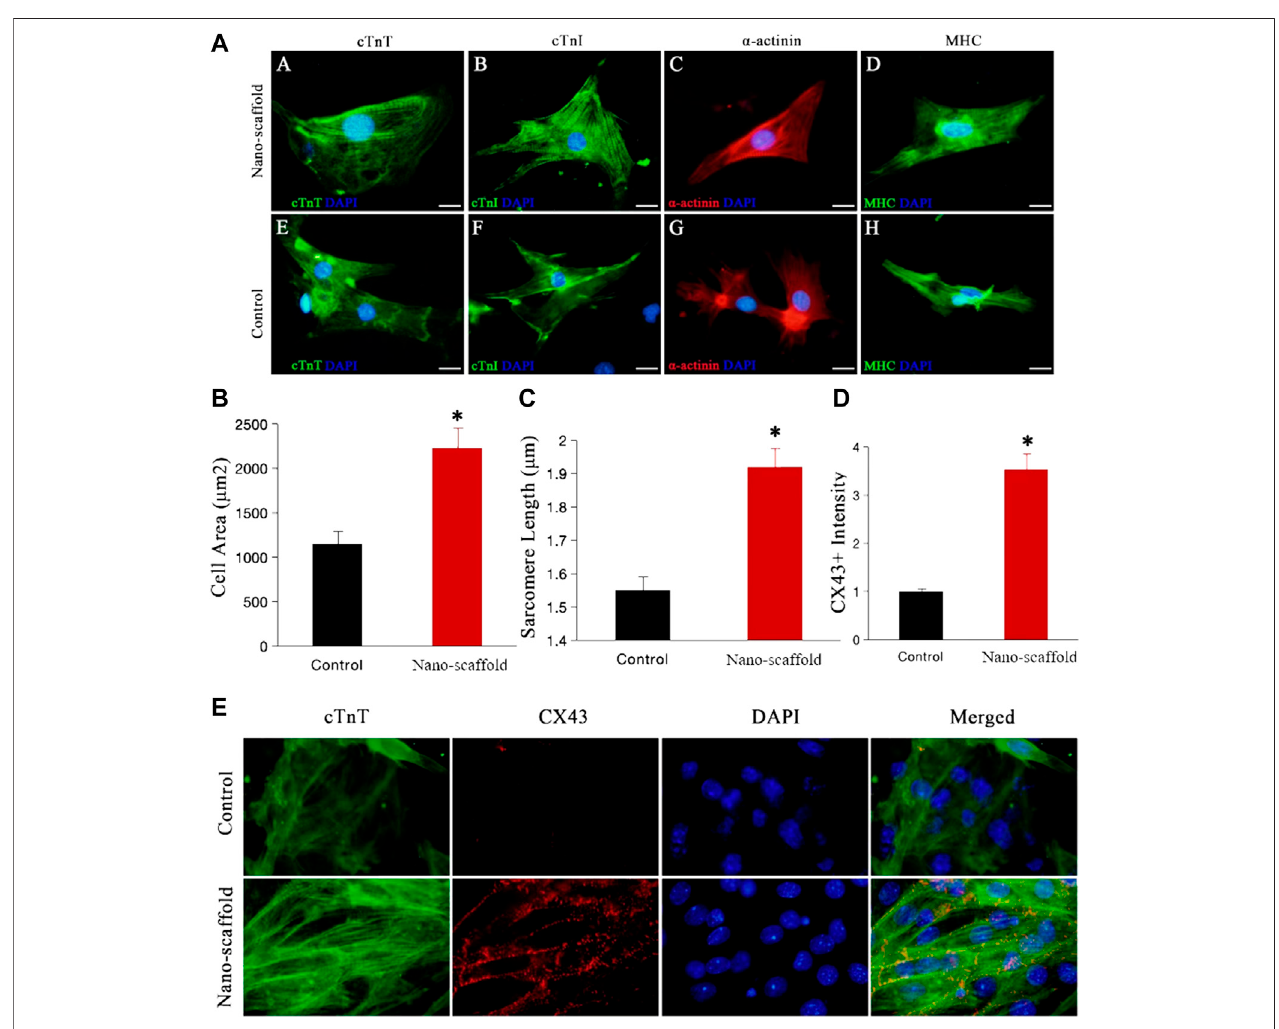
FIGURE 3 | Confocal microscopy was used to evaluate the structural maturation of iPSC-CMs cultured on nano fi brous scaffold. (A) Fluorescence expression of cardiac-speci fi c structural protein (cTnI, MHC, a-actinin and cTnT) in both control and nano-scaffold groups at day 15 of differentiation. Compared with the control group, iPSC-CMs cultured on nano fi brous scaffold exhibited signi fi cant changes in cell area (B) and sarcomere length (C) . (D,E) Immuno fl uorescence co-staining of cTnT with gap junction protein Cx43 in control and nano-scaffold groups and the Cx43 + fl uorescence expression was quanti fi ed. Data are presented as mean ± SEM, * p < 0.05 vs.